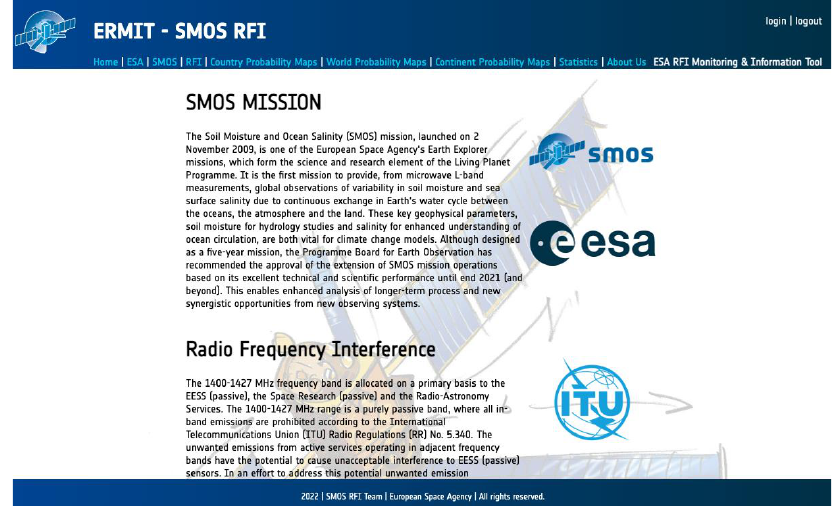
Figure 7. ERMIT home page.